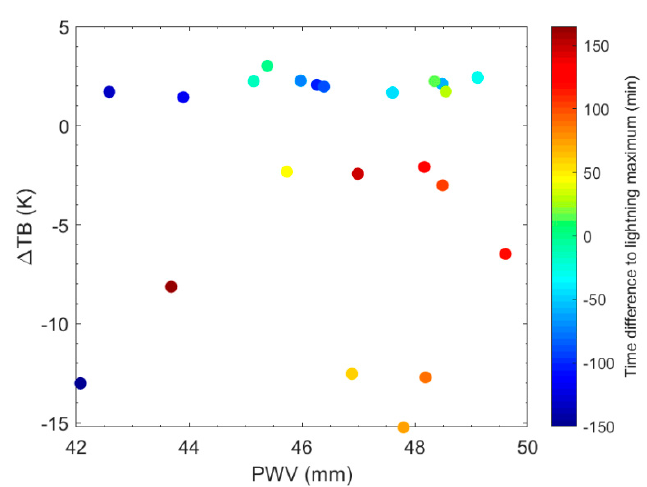
Figure 5. Scatterplot of PWV as a function of strokes intensity.